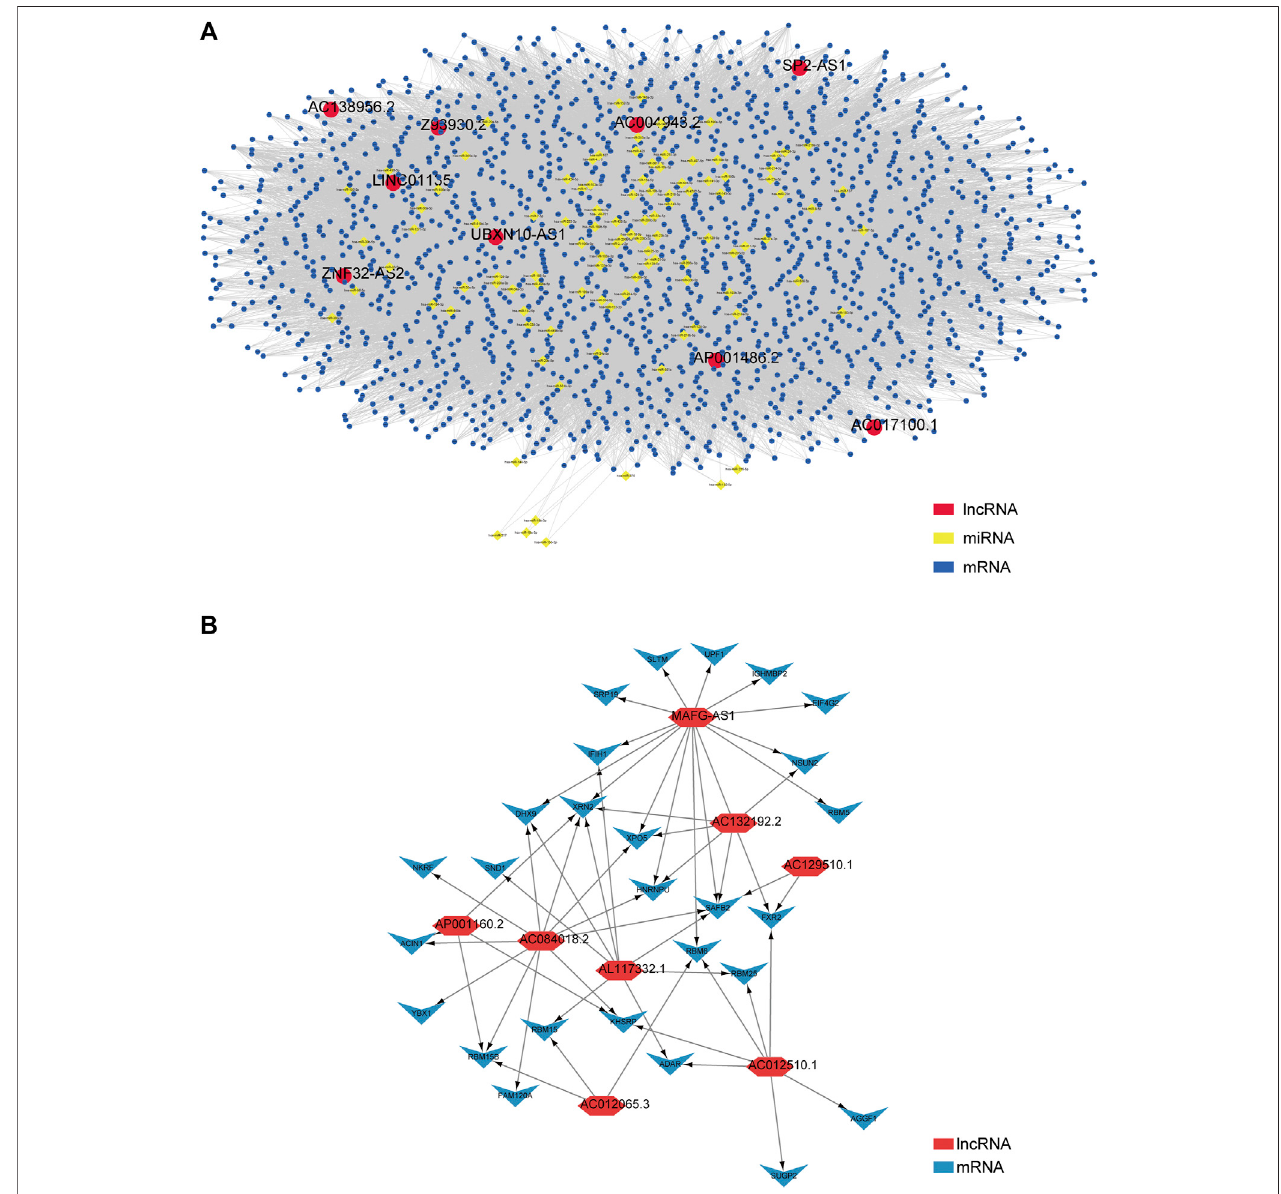
FIGURE 4 | Construction of the ceRNA network and lncRNA – protein network based on the 17 prognostic m5C-related lncRNAs in PCa patients. (A) A ceRNA network containing 9 lncRNAs ( UBXN10-AS1 , AC138956.2 , ZNF32-AS2 , AC017100.1 , AC004943.2 , SP2-AS1 , Z93930.2 , AP001486.2 , and LINC01135 ), 106 miRNAs, and 1710 mRNAs shows their lncRNA – miRNA – mRNA pathways interaction. (B) A lncRNA – protein interaction network relates to the rest of 8 lncRNAs ( AC012510.1 , AC012065.3 , AL117332.1 , AC132192.2 , AP001160.2 , AC129510.1 , AC084018.2 , and MAFG-AS1 ).